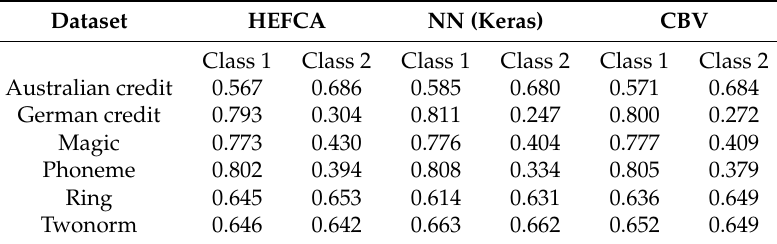
Table 3. F-measures of HEFCA, neural network and